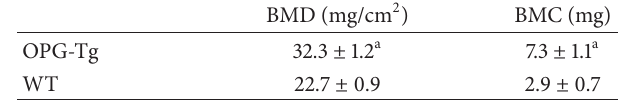
Table 2: Comparison of trabecular bone structural Table 1: Femur overall bone mineral density and bone mineral content of two types of mice. BMD (mg/cm 2 ) BMC (mg) OPG-Tg 32.3 ± 1.2 a WT 22.7 ± 0.9 2.9 ± 0.7